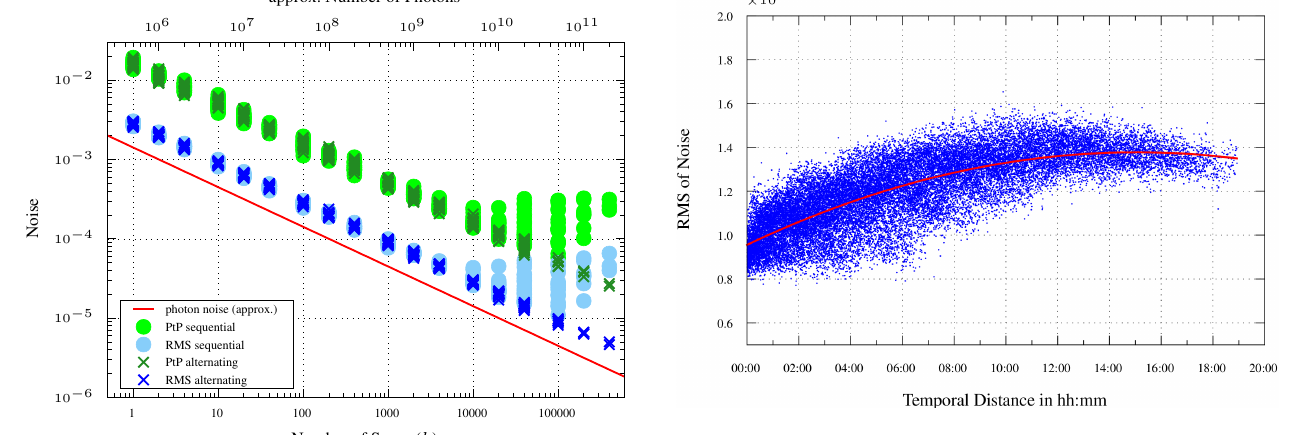
Figure 11. Development of the noise for spectra with 1000 co- added scans and increasing temporal distance. Within a few hours a slight increase in noise could be observed. Since photon noise does not change with time, the increase must have its origin in a changed instrument noise. The red line shows a polynomial fit of second or-